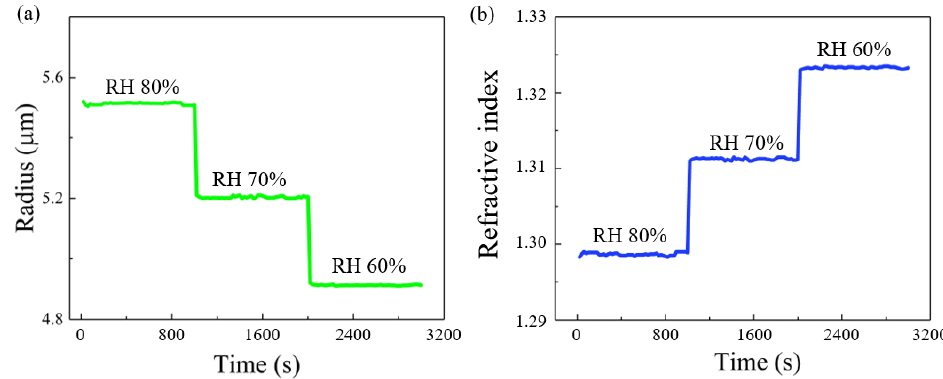
Figure 3. ( a ) KCl microdroplet radius and ( b ) refractive index as functions of irradiation time under different ambient relative humidity (RH) conditions.